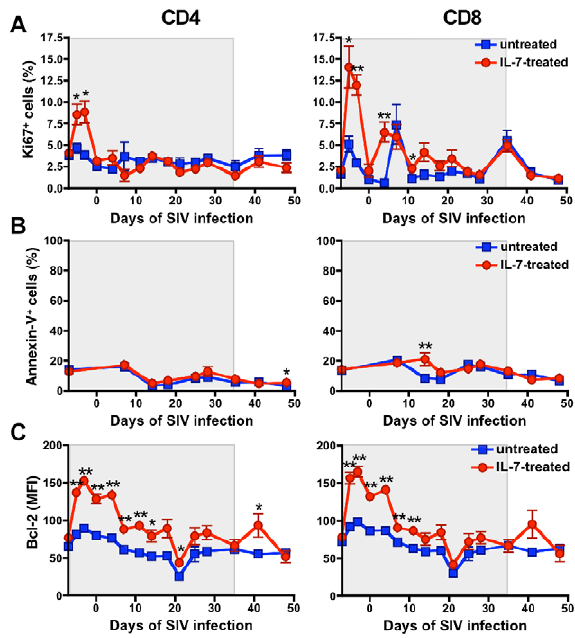
Figure 4. Effect of IL-7-treatment on cellular proliferation, apoptosis and Bcl-2 expression in peripheral blood T cells. (A) Mean levels ( 6 SEM) of cellular proliferation, as measured by expression of the cell-cycling marker Ki67, in CD4 + and CD8 + T cells freshly isolated from untreated (blue) and IL-7-treated (red) animals. (B) Mean levels ( 6 SEM) of spontaneous apoptosis, as measured by Annexin-V binding, in circulating CD4 + and CD8 + T cells from untreated (blue) and IL-7-treated (red) animals. (C) Average MFI levels ( 6 SEM) of Bcl-2 expression in circulating CD4 + and CD8 + T cells from untreated (blue) and IL-7-treated (red) animals. The grey shaded area indicates the IL-7-treatment period. The asterisks denote significant differences between untreated and IL- 7-treated animals (* p , 0.05, ** p , 0.01, by Wilcoxon rank sum test).